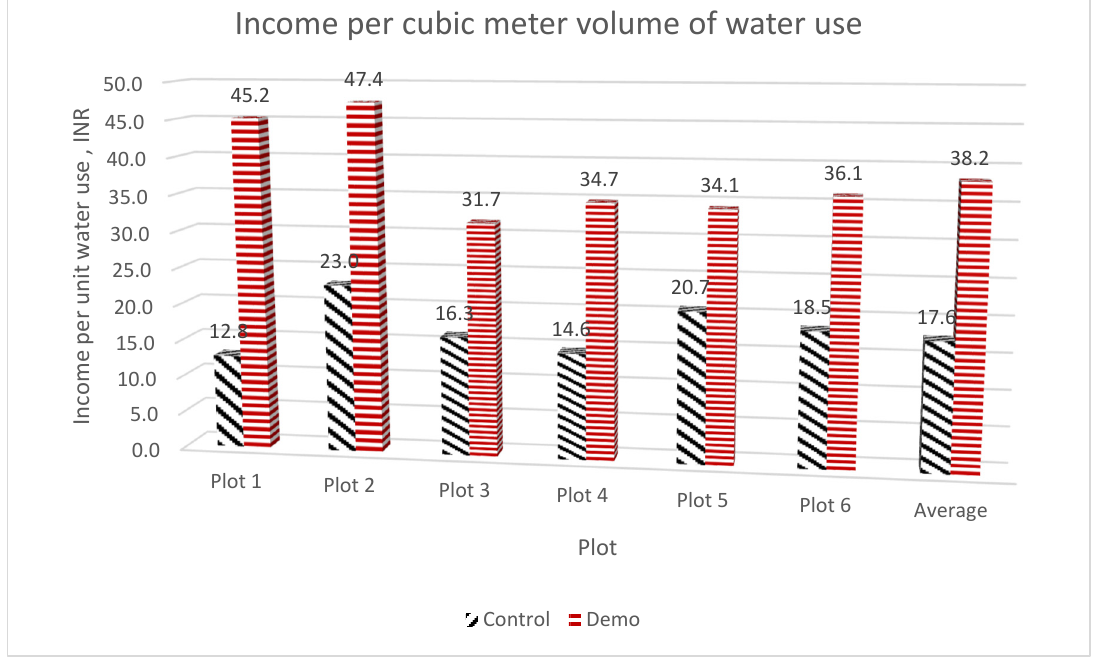
Figure 9. A comparison of income per cubic metre of water use (Better Management Practices including trench vs traditional methods).